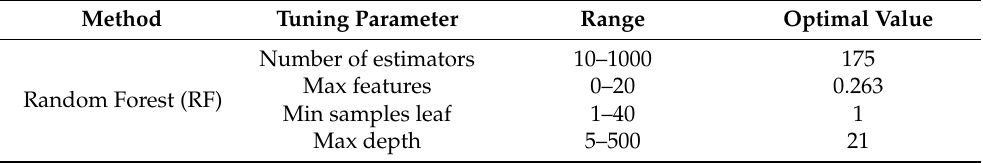
Table 3. The optimal tuning parameters of RF were optimized by considering nature-inspired methods.